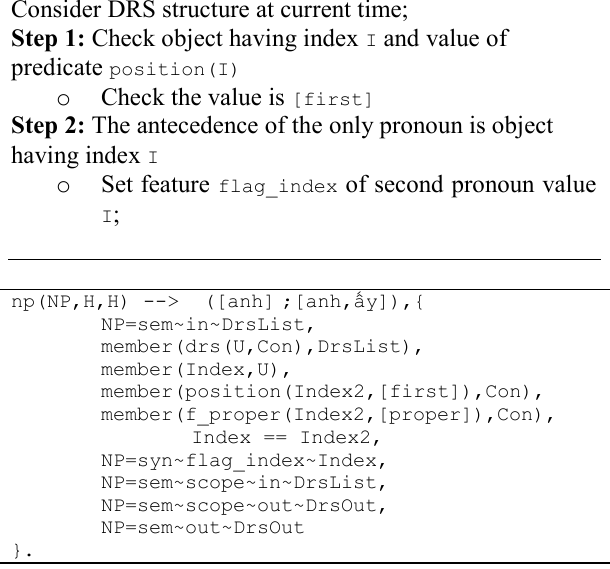
Algorithm 1 : Determine the antecedent for the only pronoun with finding strategy in group A.